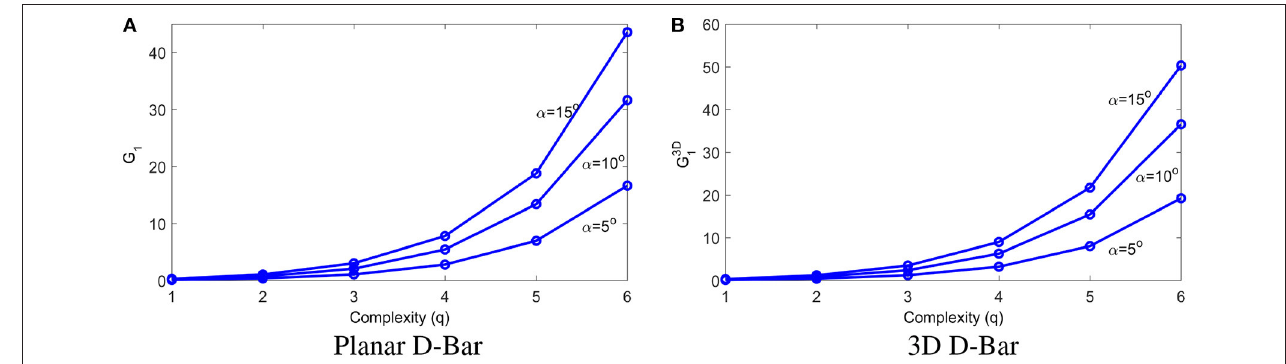
FIGURE 6 | Gains G 1 (Equation 14) and G 3 D 1 (Equation 15) for complexity q and angle α combinations. (A) Planar D-Bar. (B) 3D D-Bar.